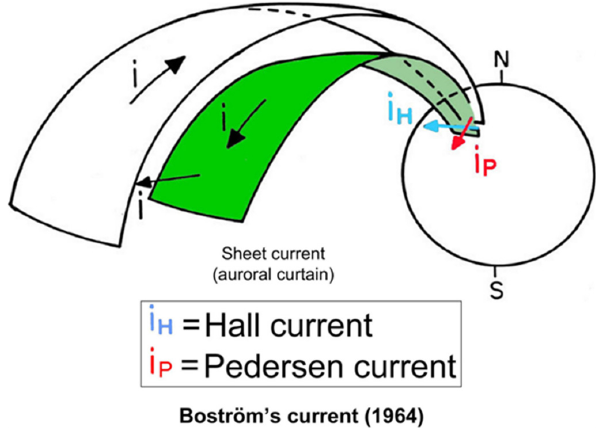
Fig. 13b. A segment of Bostrom’s meridional